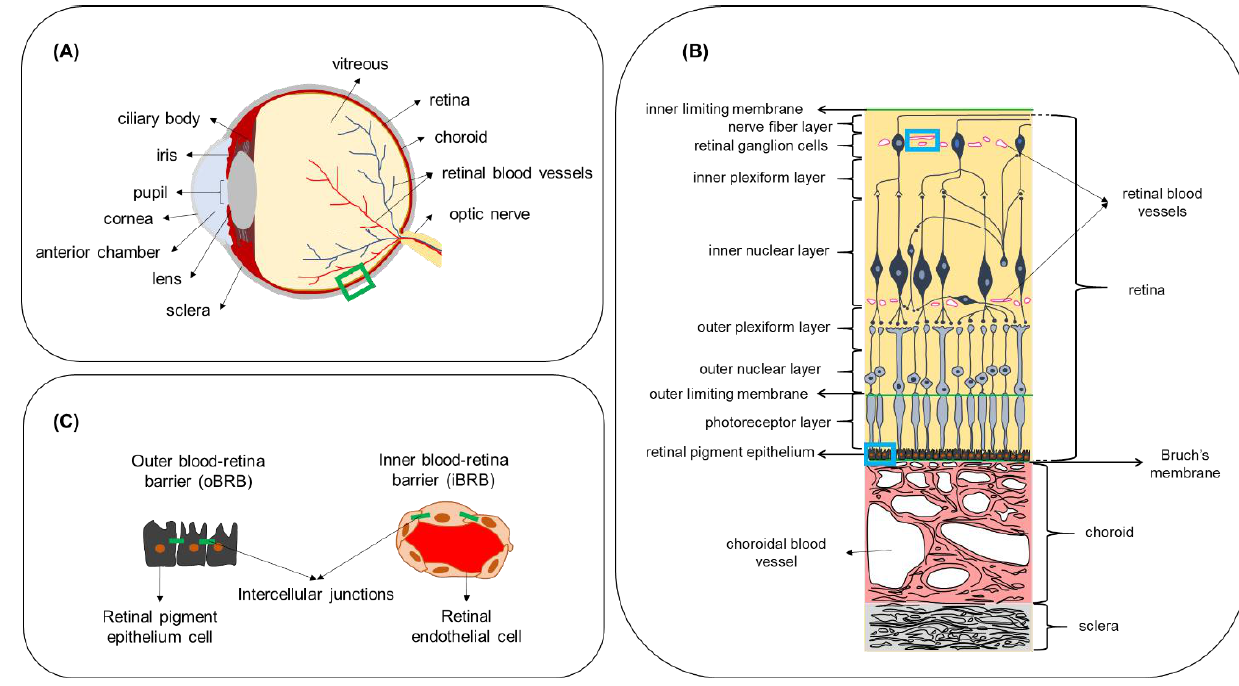
Figure 3. ( A ) Anatomy of the eye. ( B ) Boxed region (green line) in ( A ) showing a cross-section of the posterior eye with the different cell layers of the retina, Bruch’s membrane, choroid and sclera. ( C ) Boxed regions in ( B ) (blue line) showing the locations where the outer and inner blood–retina barriers are formed, due to intercellular junctions between adjacent cells. Figure not to scale.